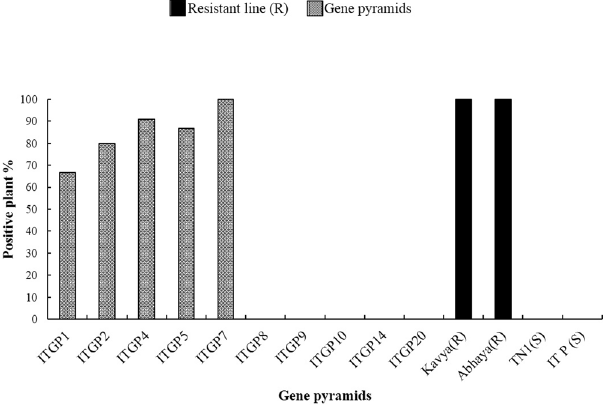
Figure 5. Disease reaction of different gene pyramids against gall midge.